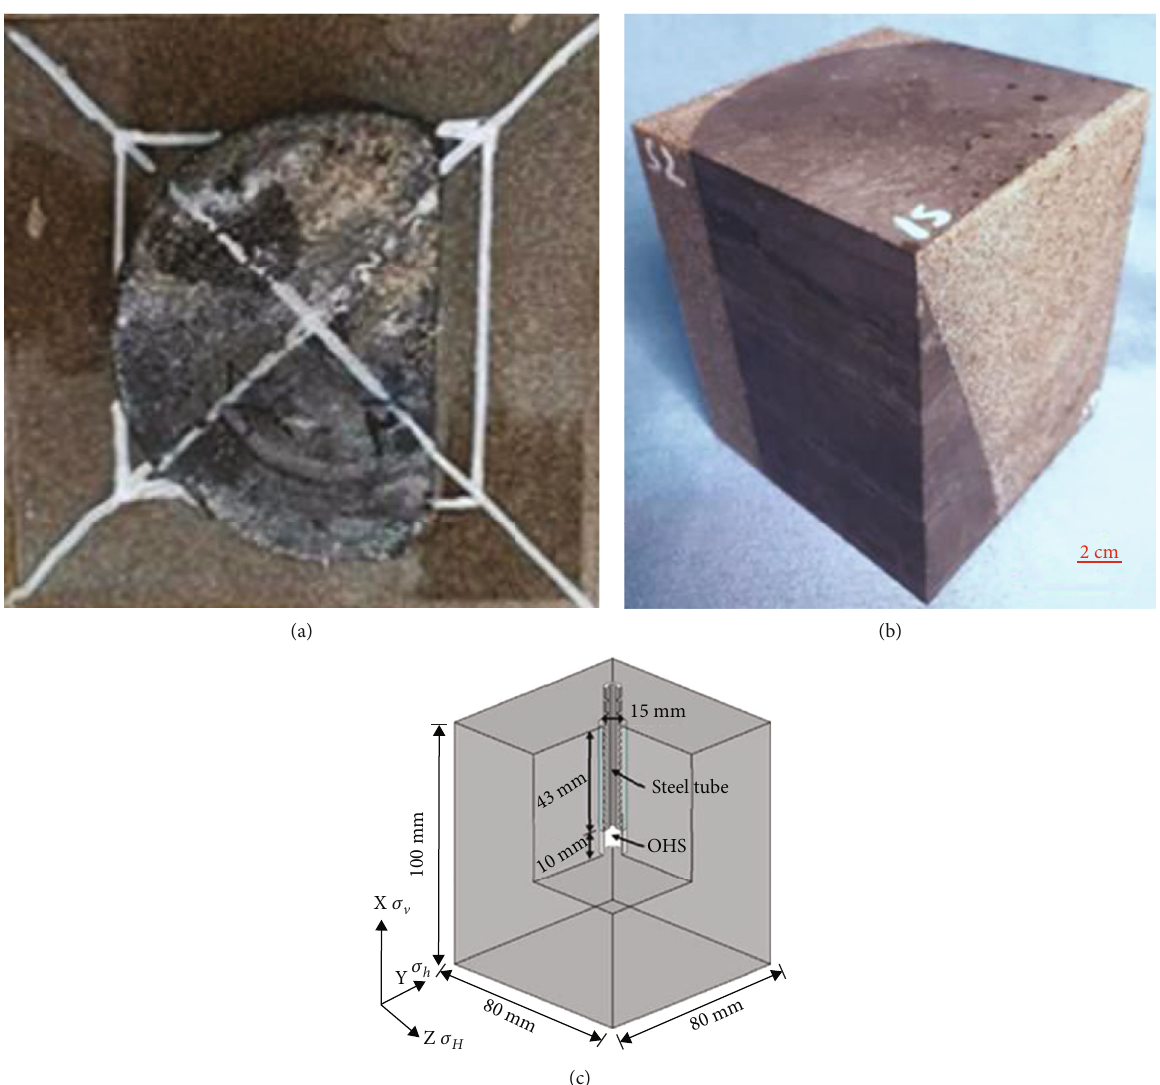
Figure 3: Schematic diagram of full diameter core and physical model sample and well completion. (a) Core sizing and setting process. (b) Fracturing test sample. (c) Schematic diagram of well